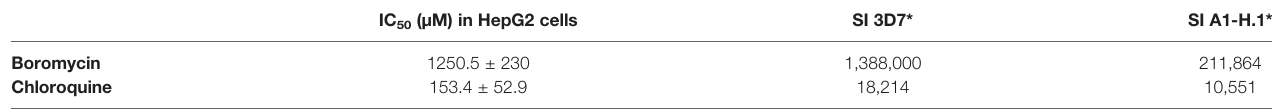
TABLE 2 | Cytotoxicity of boromycin and the comparator chloroquine against HepG2 cells and calculated selectivity